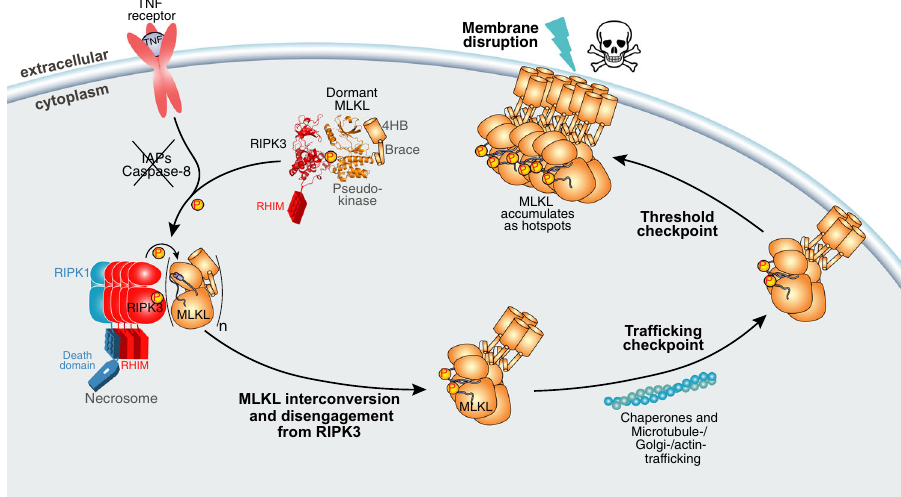
Fig. 6 A model of the transition of human MLKL from a dormant form to necroptotic effector. Human MLKL resides in a dormant state stably-complexed to RIPK3 in the cytoplasm via the bidentate interaction between MLKL and RIPK3 C-lobes. Following receipt of a necroptotic stimulus, RIPK3:MLKL complexes are recruited to the necrosome where RIPK3-mediated phosphorylation promotes MLKL structural interconversion, dissociation from the necrosome, and oligomerization 47 . Mutational perturbation of the MLKL:RIPK3 interaction prevents their stable association and recruitment to the necrosome, identifying formation of stable MLKL:RIPK3 complexes as a crucial checkpoint in the necroptotic pathway. Recruitment to the necrosome allows engagement of chaperone- and Golgi/microtubule/actin-mediated pathways to facilitate MLKL translocation to the plasma membrane 32,56,57 . Upon reaching a threshold level at the plasma membrane, MLKL can permeabilize membranes to cause cell death and damage-associated molecular pattern (DAMP) release. The skull and crossbones image (Mycomorphbox_Deadly.png; by Sven Manguard) was used under a Creative Commons Attribution- Share Alike 4.0